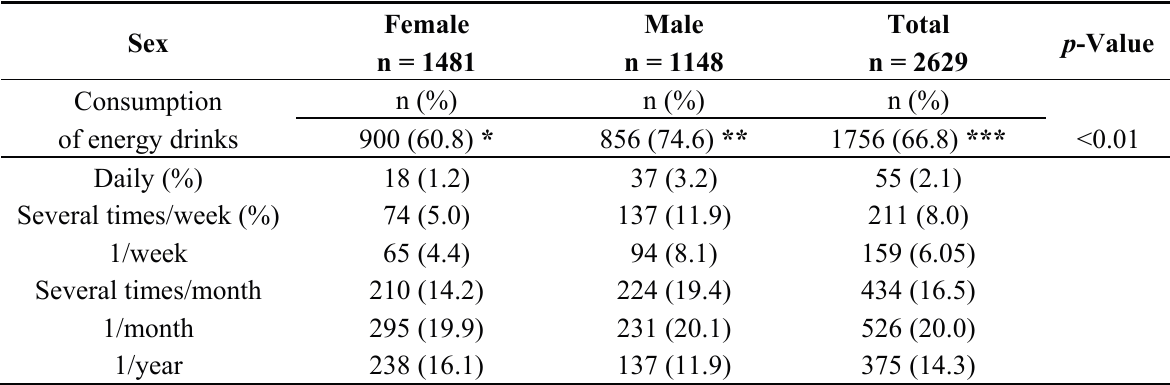
Table 1. Consumption of energy drinks by